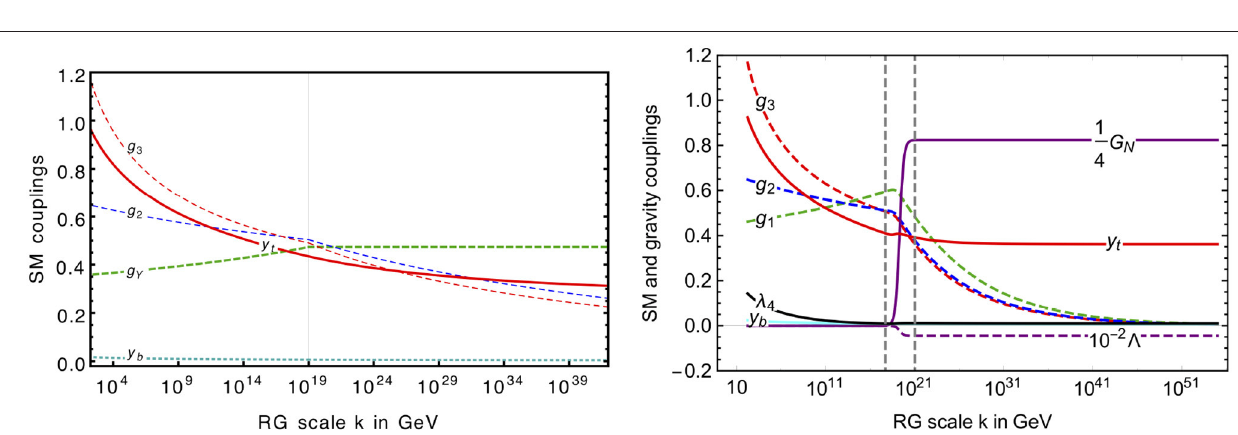
9.8 10 − 3 and f y 1.13 10 − 4 above the Planck scale and f g = · = ·